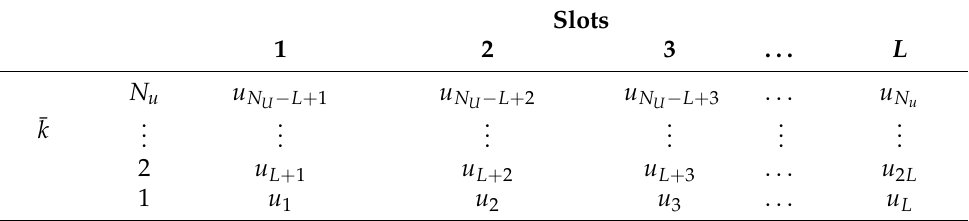
Table 2. Optimal scheduling policy allocating the users through coding levels and slots.